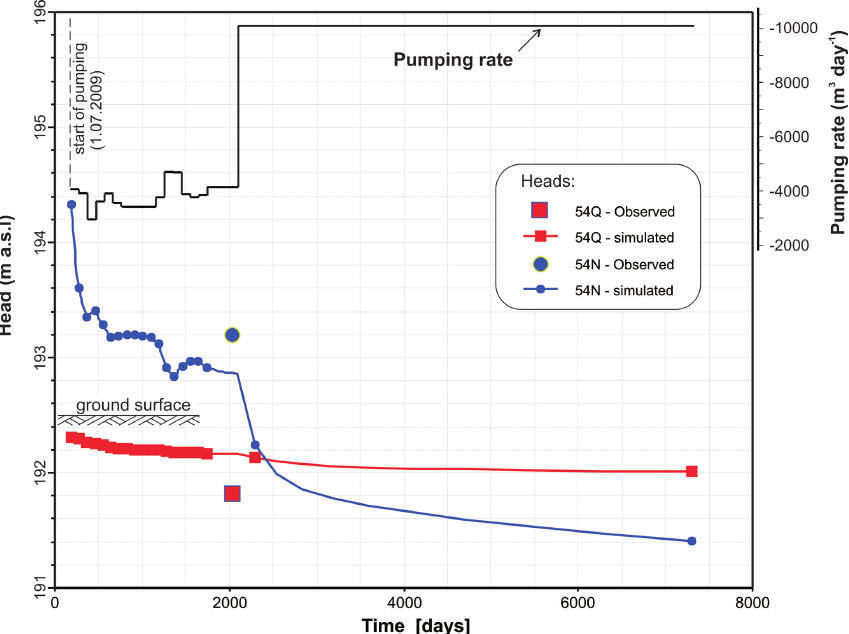
Figure 13. Changes of hydraulic heads in the shallow Quaternary and deeper Neogene aquifers in observation wells (54Q and 54N, respec- tively, see Fig. 2) simulated in the centre of the Wielkie Błoto fen. Pumping rate of Wola Batorska well field from the start in July 2009 till October 2014 was simulated as actual abstraction. The later part of the diagram shows future levels of groundwater abstraction with maximum permitted capacity (10080m 3 day − 1